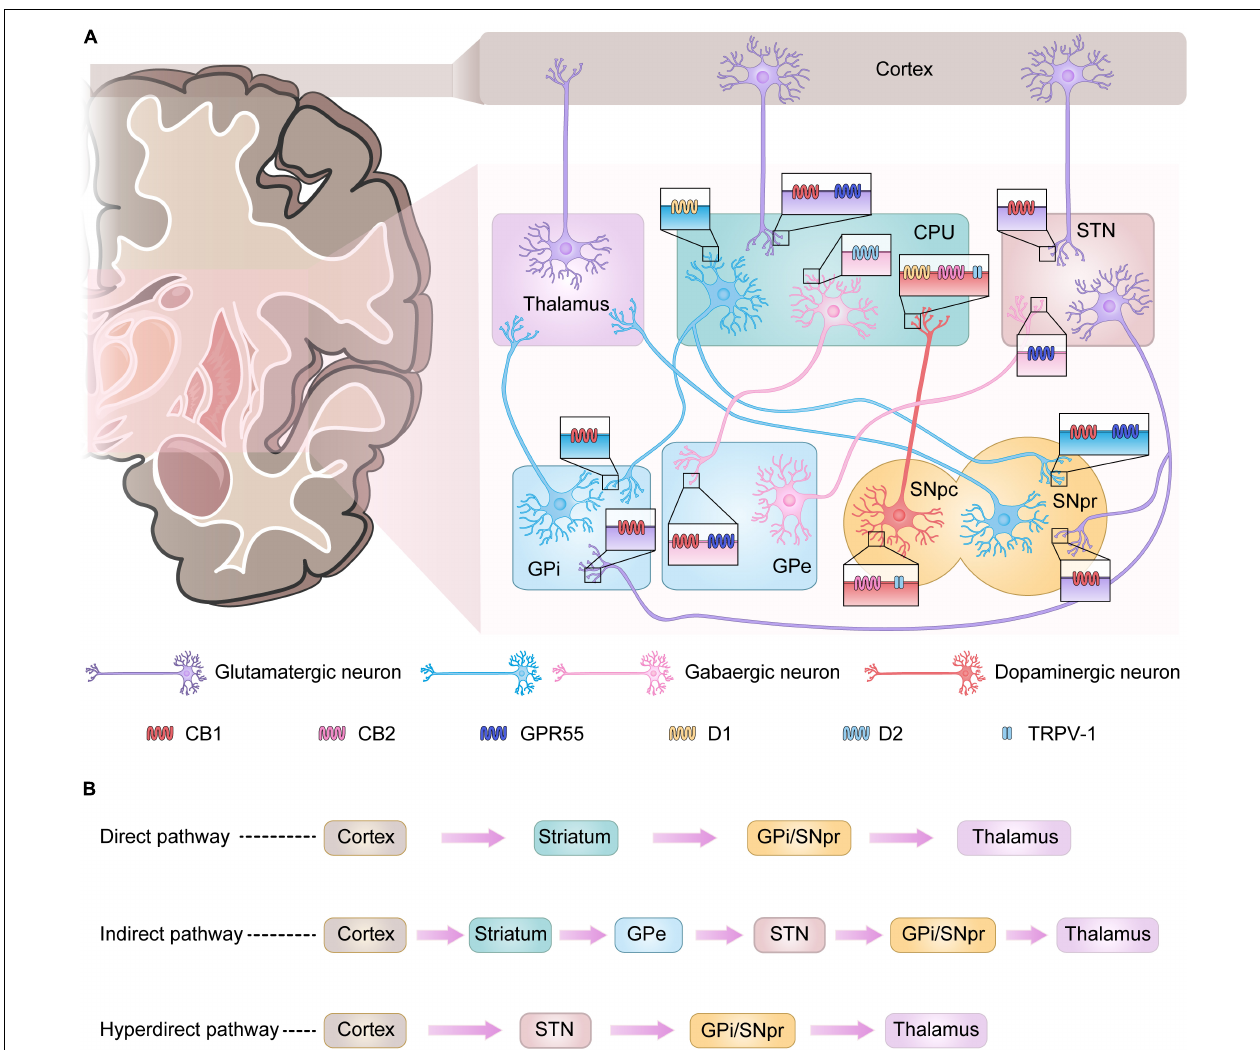
FIGURE 1 | Basal ganglia signaling pathways and associated receptor localization. (A) Signals from the cerebral cortex affect the output nuclei (GPi and SNpr) via direct or indirect pathways via the basal ganglia input nuclei (CPU), which in turn regulate thalamic motor function. In Parkinson’s disease (PD), the loss of dopaminergic neurons leads to enhanced activity in the indirect pathway and diminished activity in the direct pathway, with more output of the inhibitory neurotransmitter gamma-aminobutyric acid (GABA) from the GPi and SNpr, which depresses the motor thalamus, leading to the development of PD. Some receptors present in the basal ganglia play an important role in the regulation of signaling. CB1 receptors are mainly found in GABAergic and glutamatergic neurons. GPR55 is present in the nuclei of GPe, CPU, STN, and SNpr. CB2 receptors and TRPV-1 are mainly present in dopaminergic neurons originating from the SNpc. (B) Three major pathways of basal ganglia